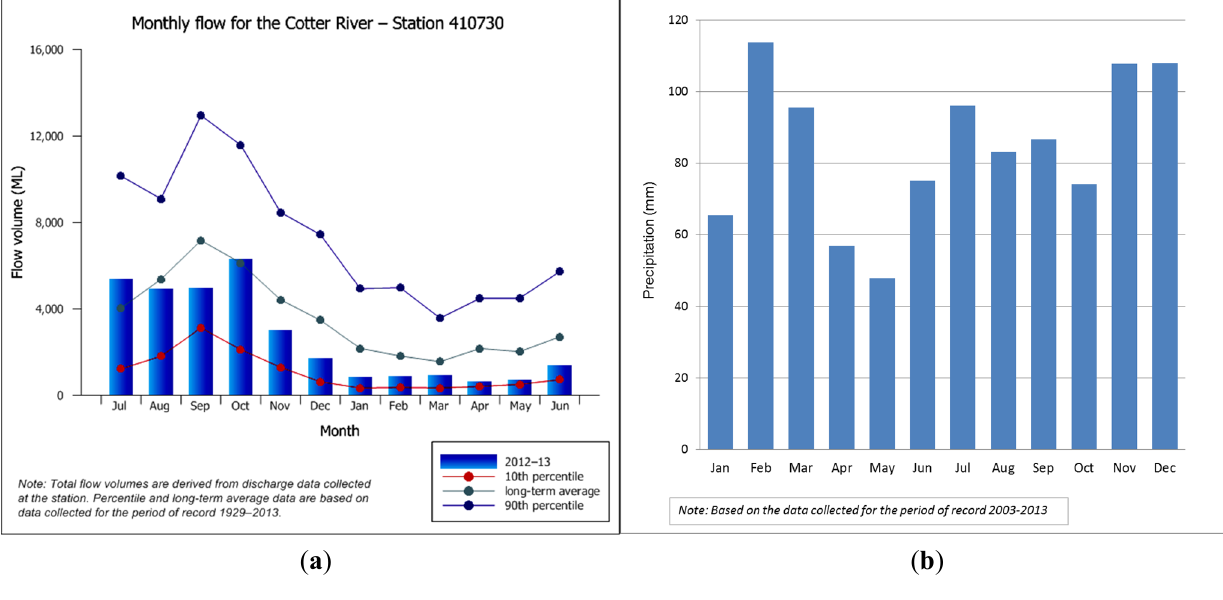
Figure 2. Annual hydrograph at the inflow of the Corin dam provided by the Bureau of Meteorology of Australia ( a ); and hyetograph at of the Mount Ginini automatic weather station ( b